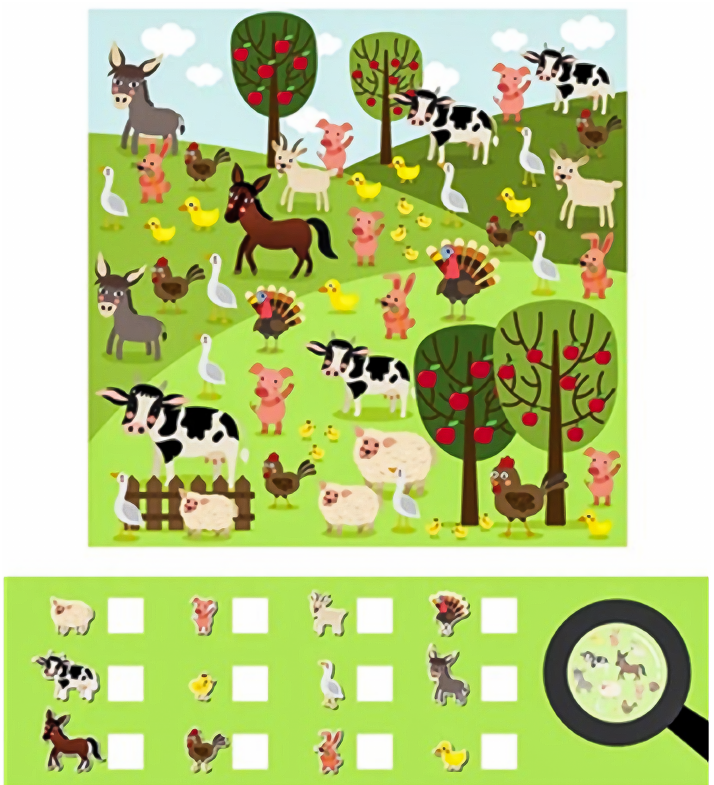
Figure 4. Example of counting animals activity sheet. This activity requires the child to identify, classify, count the animals, and write the number in the white square. The activity sheets are from https://www.actividadesdeinfantilyprimaria.com/, accessed on 29 December 2021.